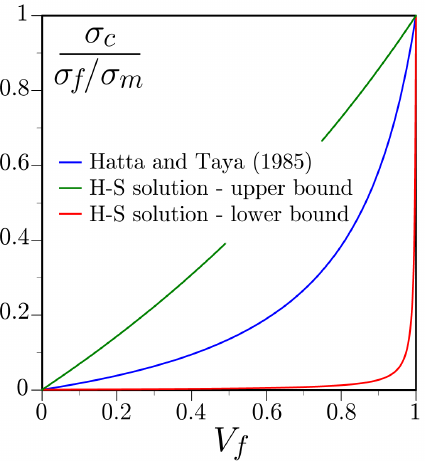
Figure 7. Relationship between fiber content and conductivity of the composite material according to two effective medium theories (for conductivity ratio σ f / σ m = 1000 and aspect ratio l f / d f =